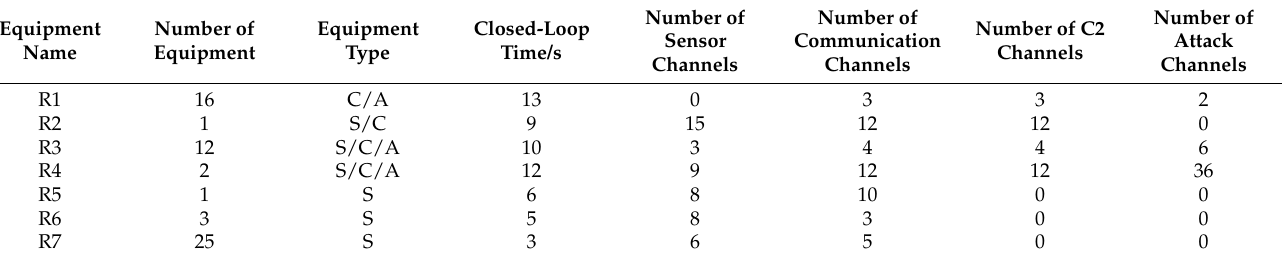
Table 2. Basic attributes of the red side’s equipment.